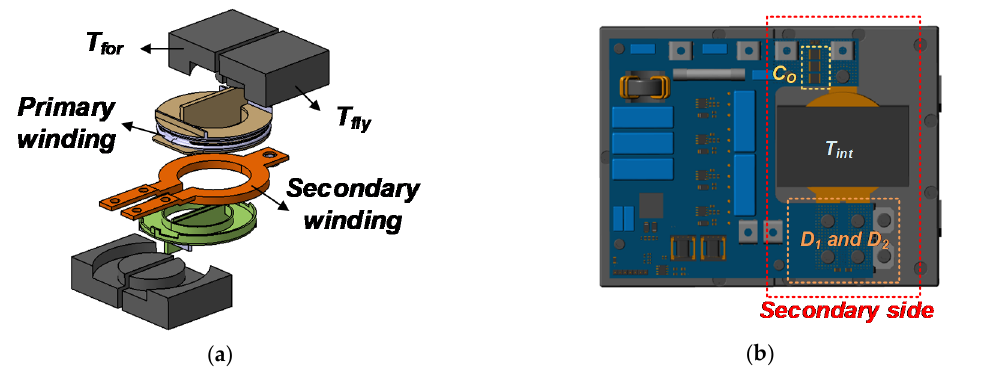
Figure 10. Integrated transformer of the proposed converter. ( a ) Structure of the integrated transformer. ( b ) Concise secondary side structure.